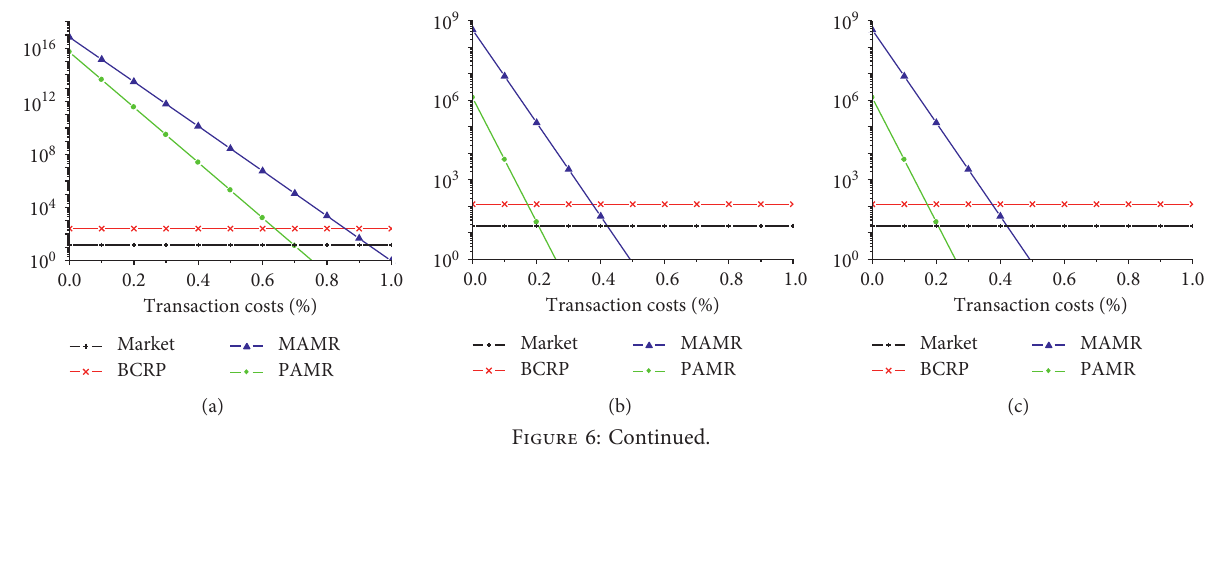
Figure 5: Parameter sensitivity of MAMR with respect to C DJIA. (e) TSE. (f)